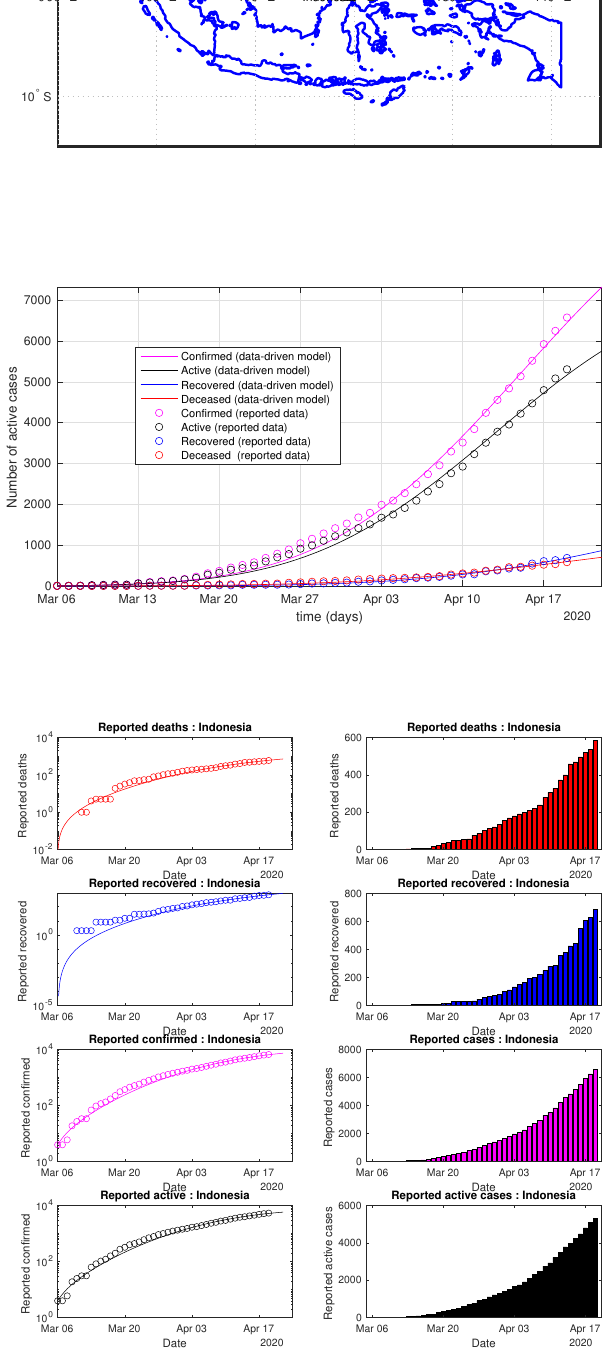
Figure 36. Indonesia: data of active, recovered, deceased (in circle or bar) vs. model of active, recovered, deceased over time. Tracking the number of active cases. Predictive analytics for the next couple